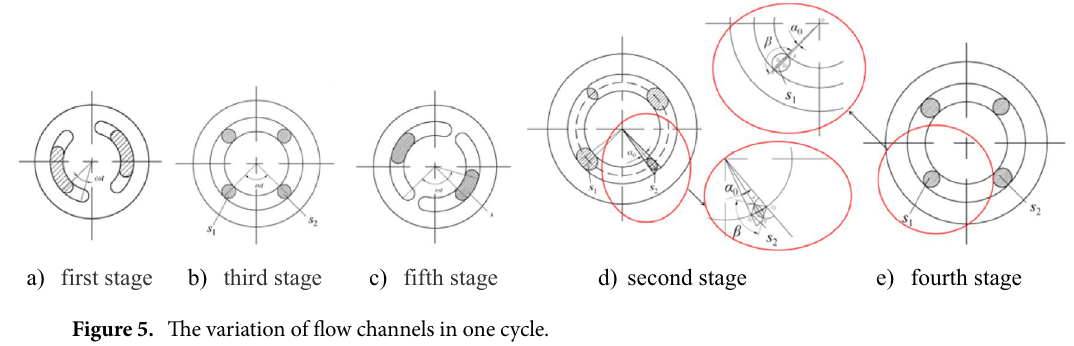
Figure 5. The variation of flow channels in one